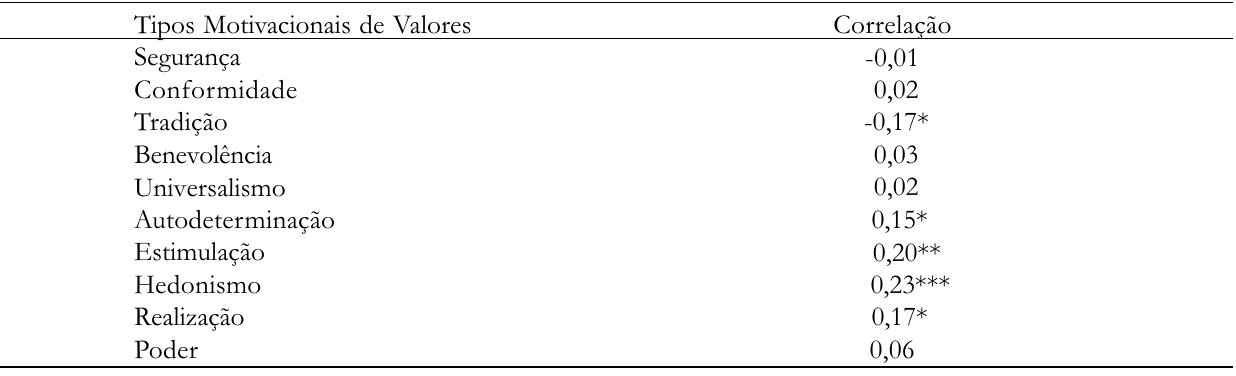
Tabela 2. Correla(cid:231)ıes Bivariadas entre os TMV e o Uso de